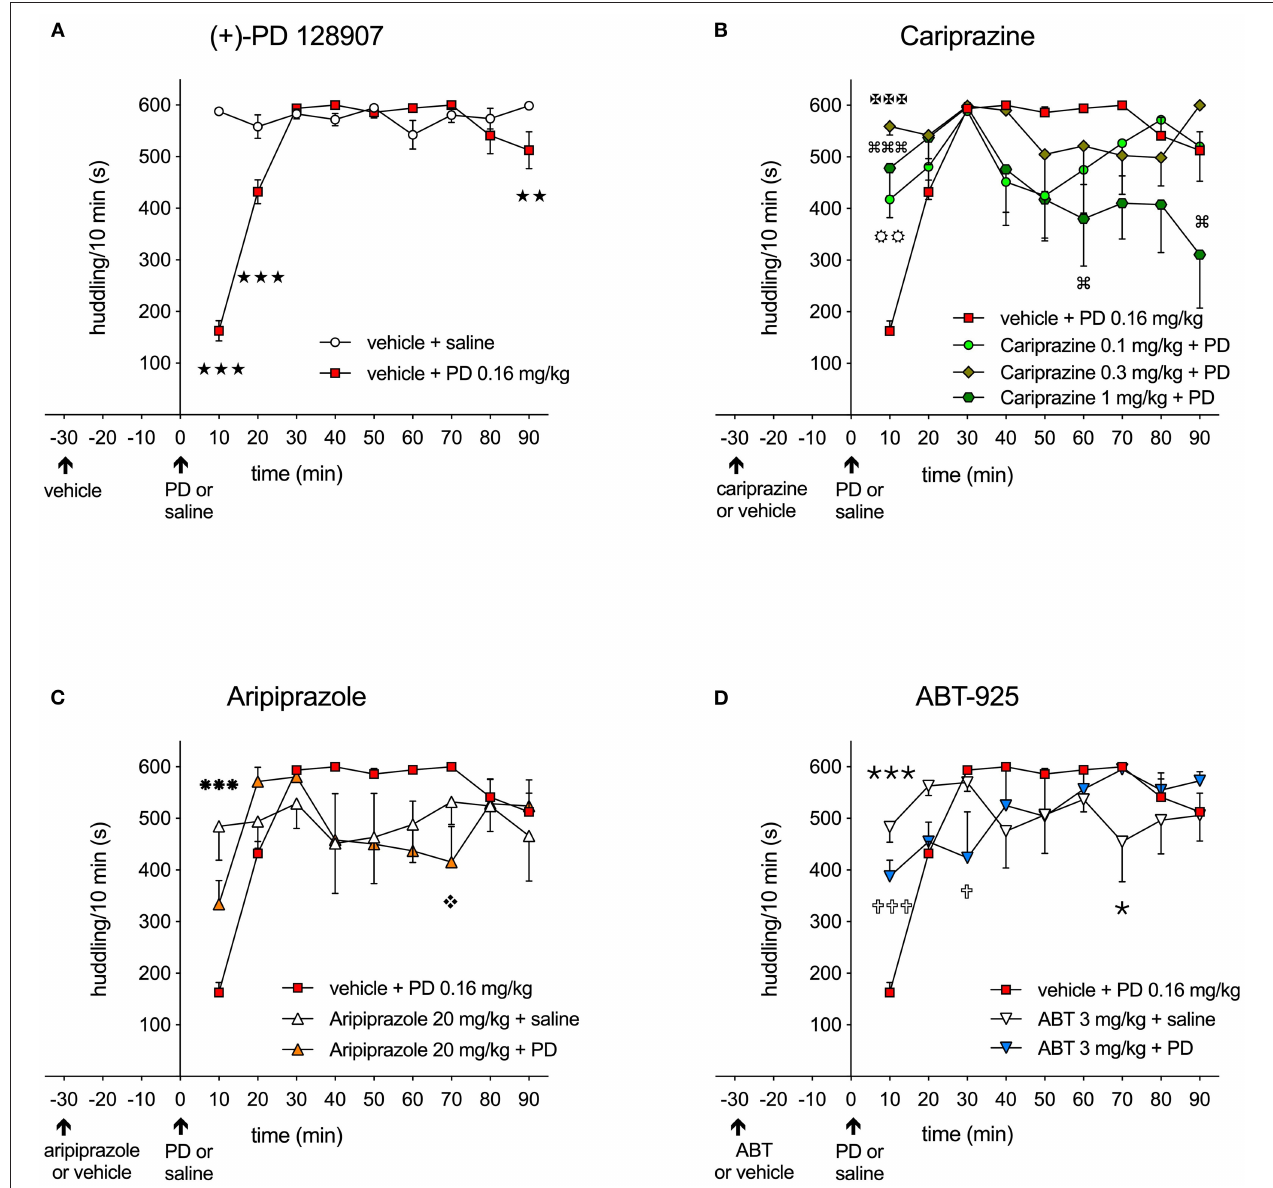
FIGURE 2 | (A) Effect of the D 3 /D 2 receptor agonist ( + )-PD 128907 (0.16 mg/kg s.c.) on disruption of huddling behavior in rats over 10-minute intervals compared to the saline-injected group (stars); ( ) P < 0.001,